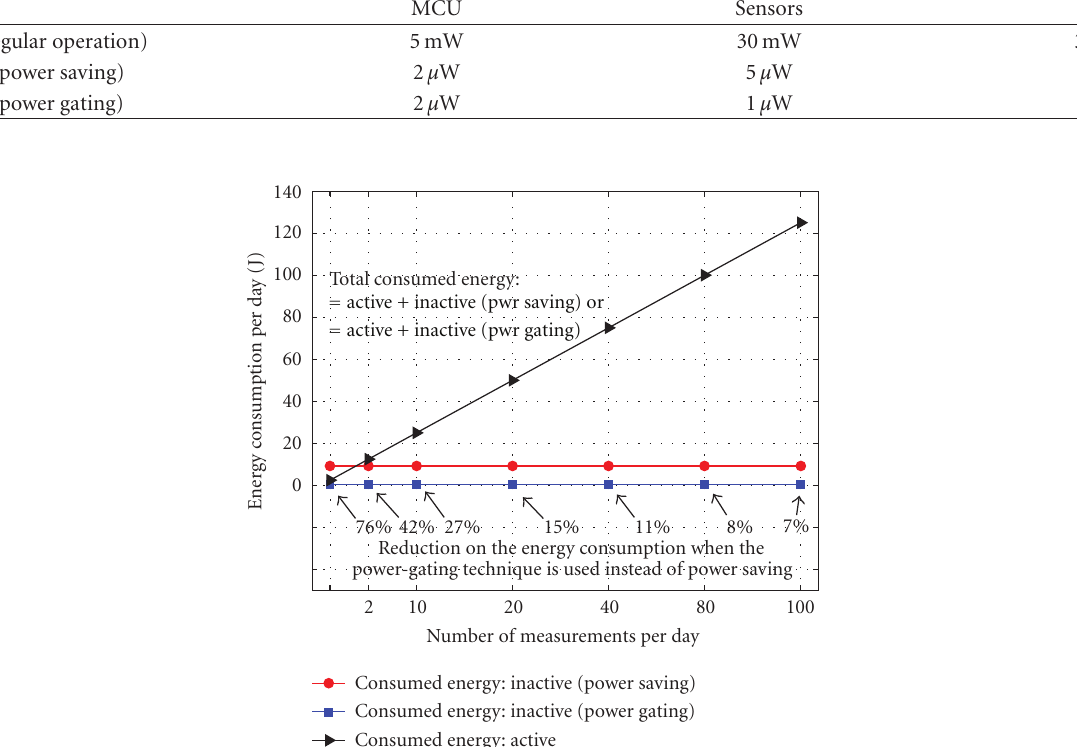
Figure 2: Energy consumption of a WSN node in an ideal scenario for di ff erent application duty cycles. Modules not being used are disabled using two techniques: power-saving and